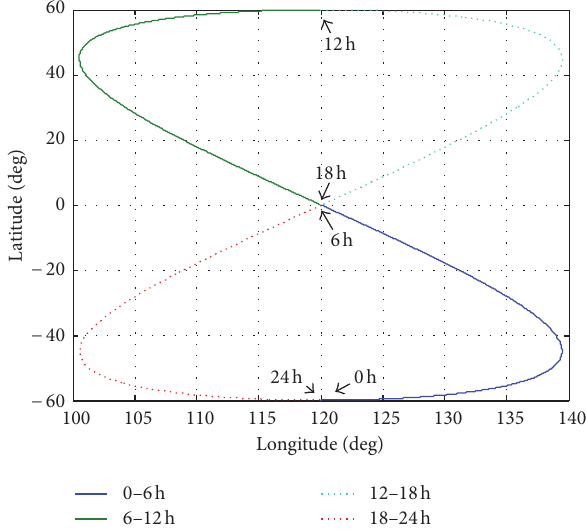
Figure 1: Ground track of 60 ∘ inclined geosynchronous orbit.